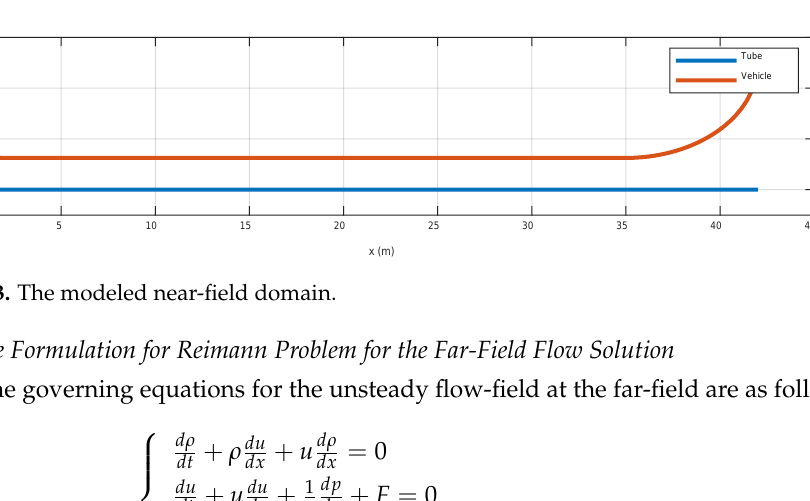
per Figure 2. Simplified skin friction coefficient formula based on the Reynolds number for a laminar boundary layer over a flat plate is used. Figure 3 describes the scale for the duct net shape for the axisymmetric model describing the near-field domain. The vehicle radius location corresponds to the 0.56 blockage ratio, and other ratios will be addressed when highlighting its effect. When varying the blockage ratio, the effec- tive vehicle radius is the crucial variable to apply this change.